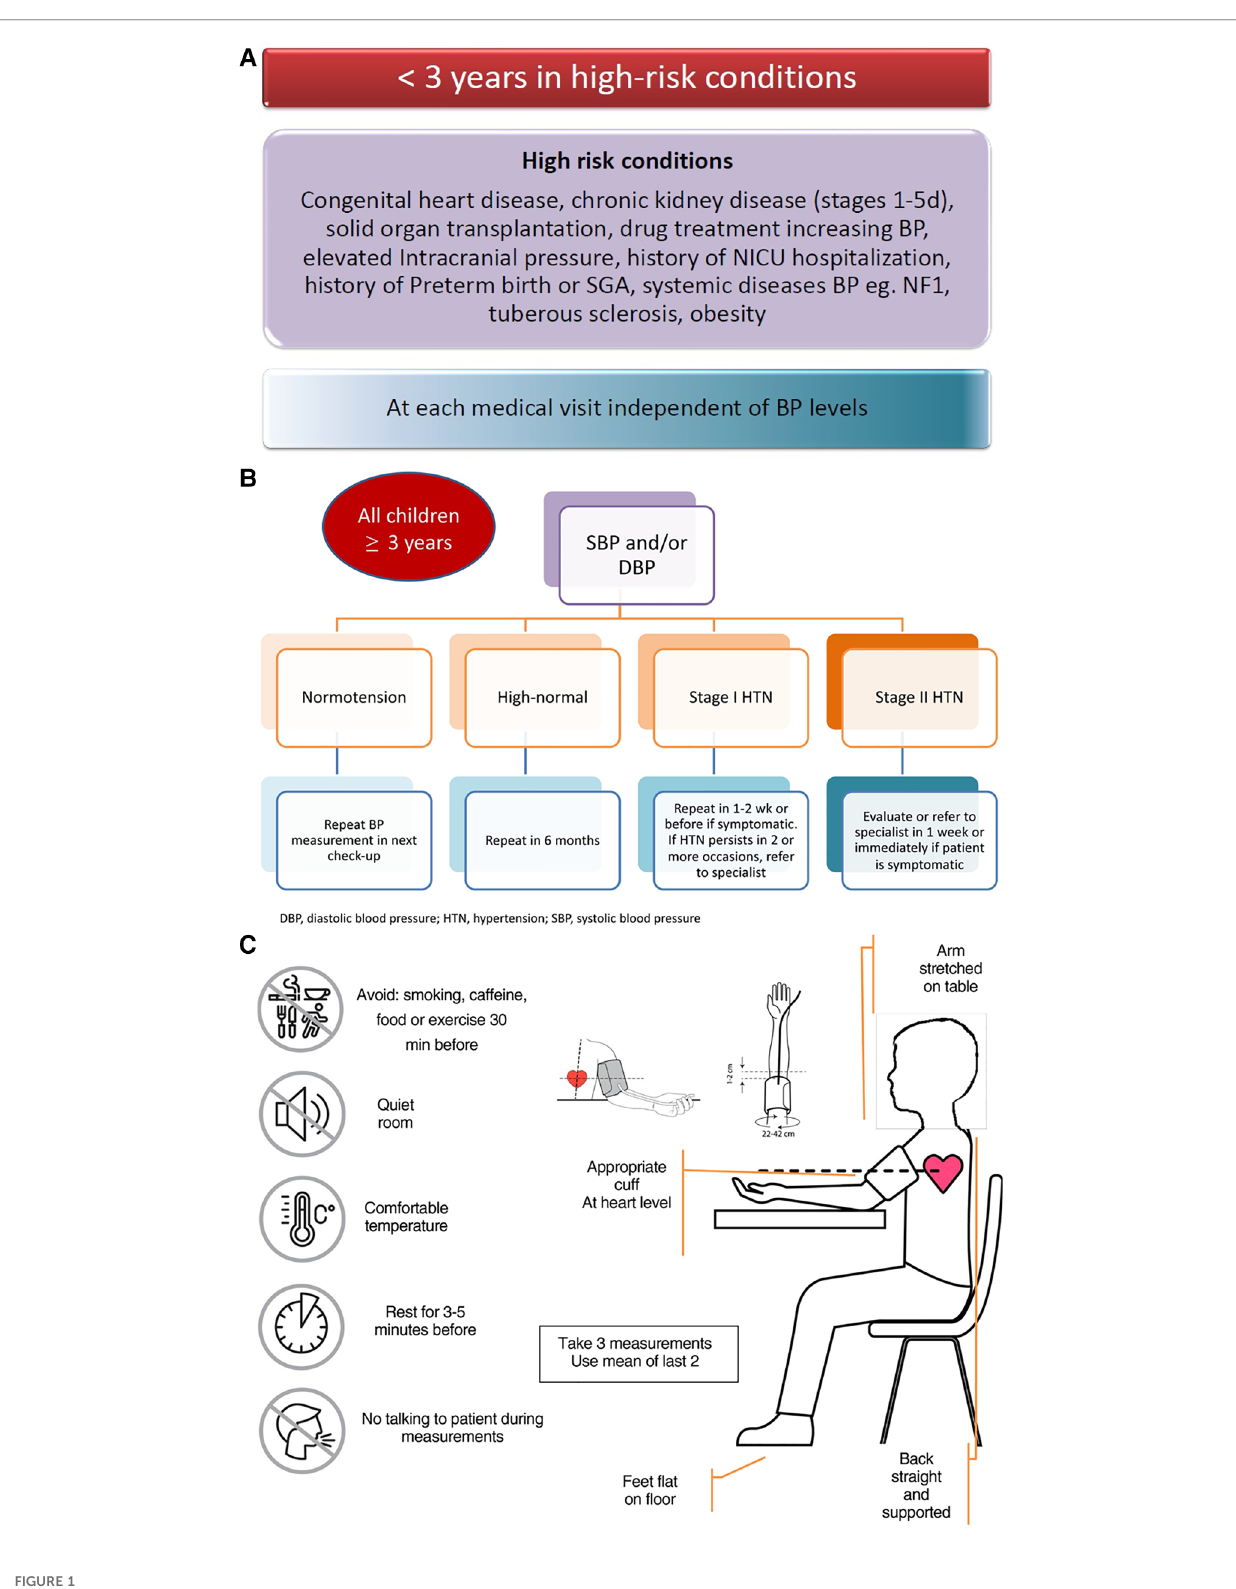
FIGURE 1 (A-C) Algorithm for frequency of of fi ce BP measurement and